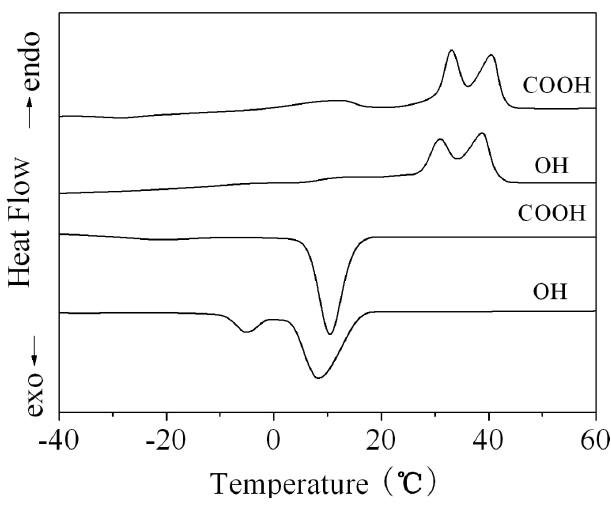
Figure 6. DSC thermograms of hydroxyl terminated and carboxylic terminated PECP copolymers.